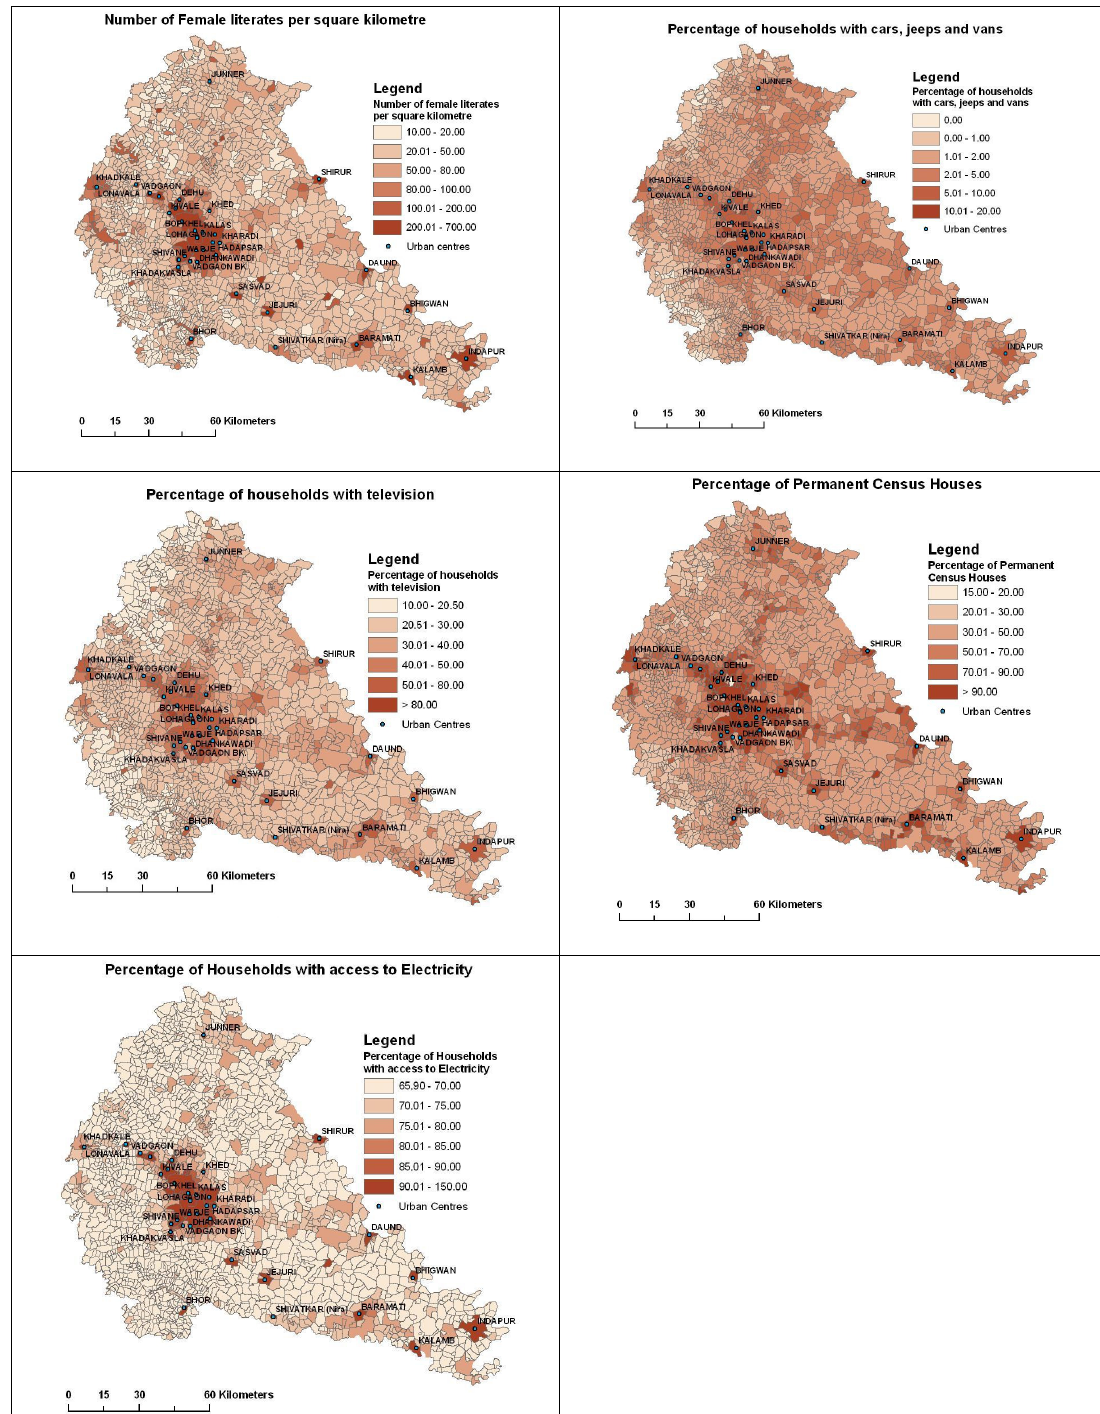
Figure 2: Maps of predicted census metrics for the villages of the district of